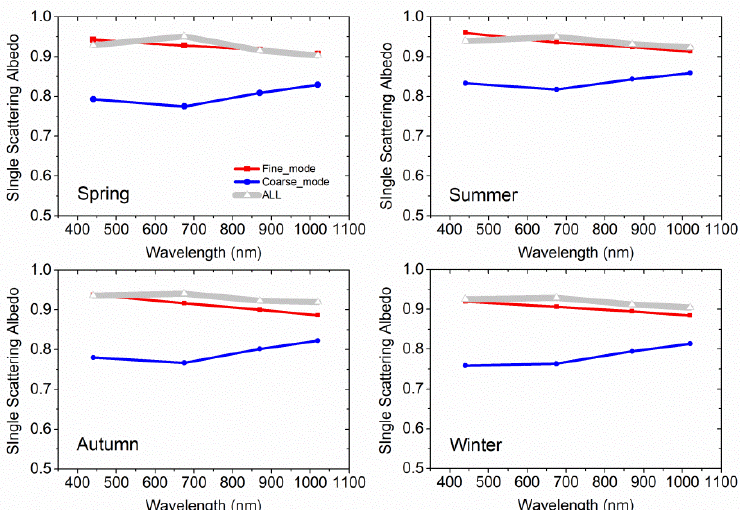
Figure 8. The sub-mode single scattering albedo in different season based on the separated volume size distribution and sub-mode complex refractive index (ignore the influence of nonsphericity on dust aerosols). The grey, red, blue lines are the whole-, fine- and coarse-mode single scattering albedos (SSAs), respectively.